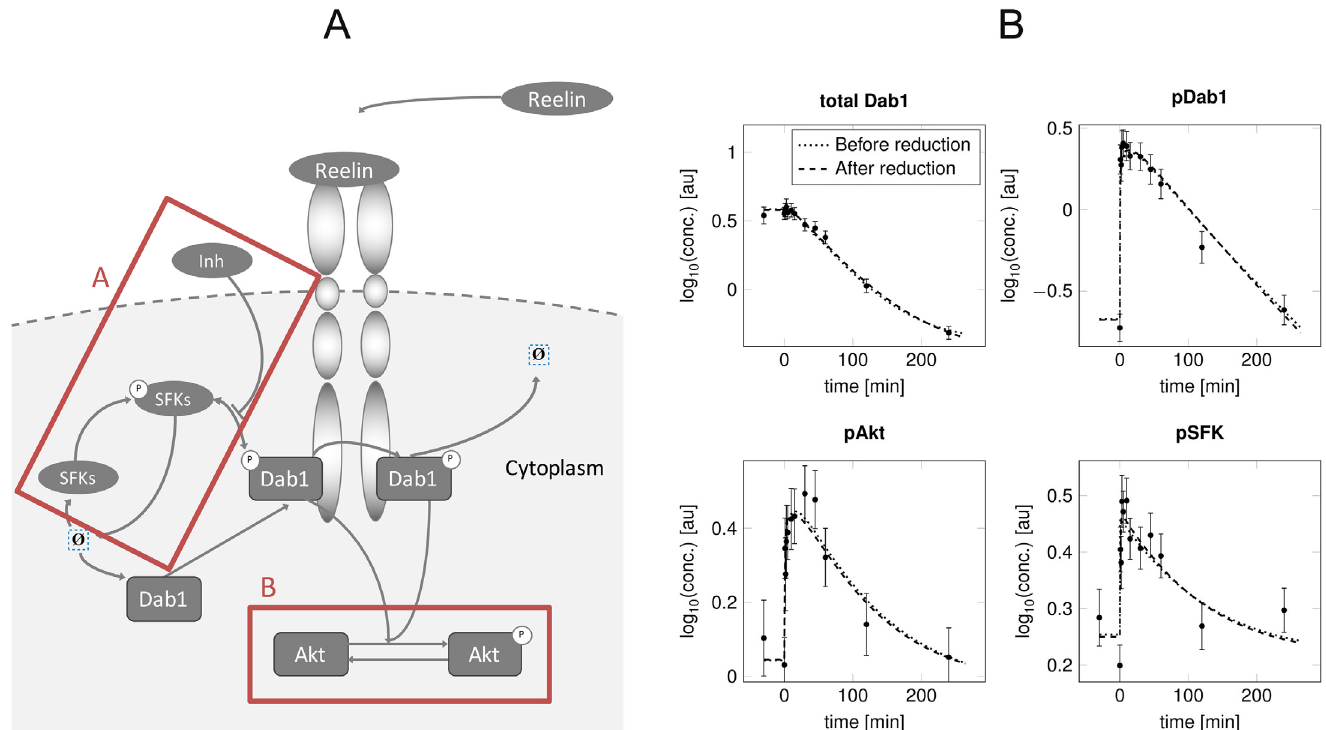
Fig 7. Reelin-induced signalling pathway. A : Scheme of the Reelin-induced signalling pathway. Sub modules that underwent model reduction are framed. B : Experimental data and model trajectories of the Reelin model. Data points and their measurement errors are shown on a log-scale for the measurements of total Dab1, phosphorylated Dab1, Akt and SFKs for time points between zero and 240 minutes. Dotted and dashed lines indicate the model response for the parameter set before and after model reduction, respectively.